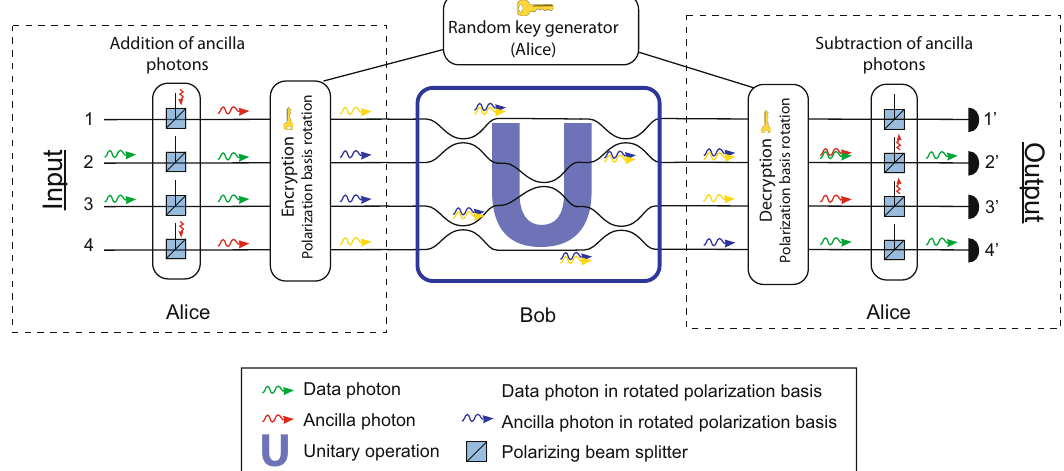
Fig. 1 Homomorphic encryption scheme. a Phase shifters and directional couplers can be used to implement any desired unitary transformation for arbitrary dimensions, either for single- or multi-photon states 27,28 . In the case of indistinguishable photons entering the circuit simultaneously, quantum interference leads to nontrivial outputs of a so-called quantum walk computation. b If two orthogonally polarized photons enter the circuit at the same time they are distinguishable and therefore no quantum interference takes place. c In the implemented quantum homomorphic encryption scheme, Alice prepares her input state by encoding the desired photon-number state in the { H , V } polarization basis and then encrypting it by applying a randomly chosen polarization transformation on all photons. Bob performs the quantum computation on the encrypted state and returns the photons to Alice. Alice undoes the previous transformation ( R − 1 ) and measures the photons in the { H , V } basis, obtaining the outcome of the quantum computation. Since Bob has no information about the polarization basis chosen by Alice, his information about Alice ’ s input state is